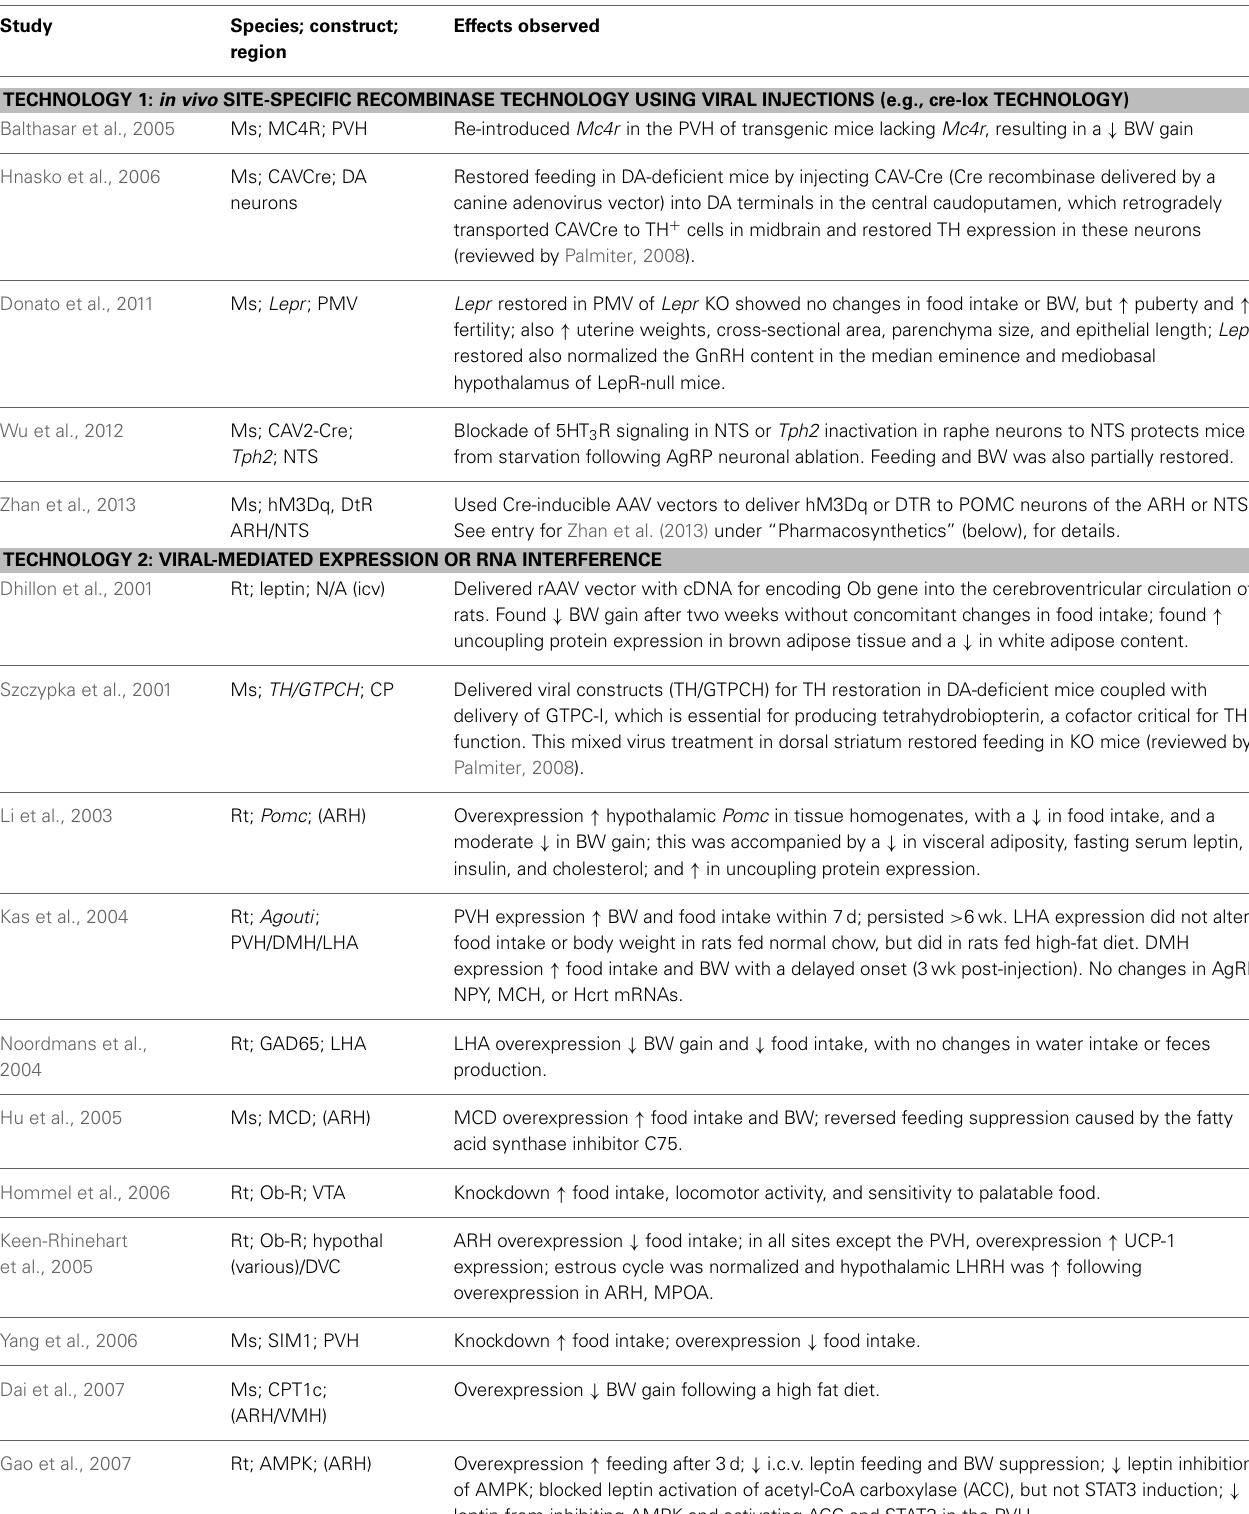
Table 2 | Transgenic technologies employed in selected IGI studies on feeding